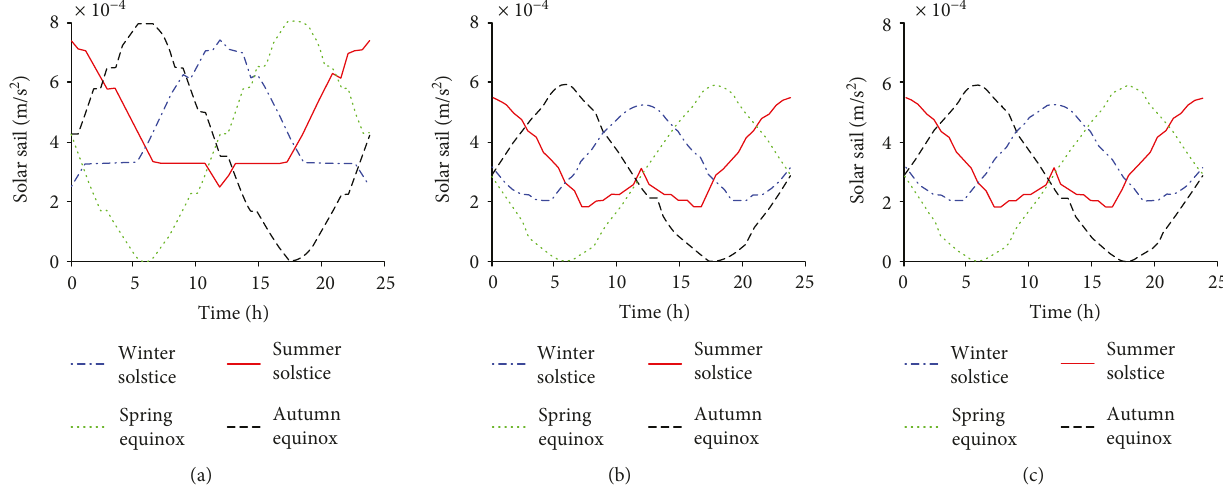
Figure 5: Strict formation on ideal displaced GEO for the hybrid sail case: acceleration provided by solar sail (a) leader, (b) follower 1, and (c) follower 2 in the frame